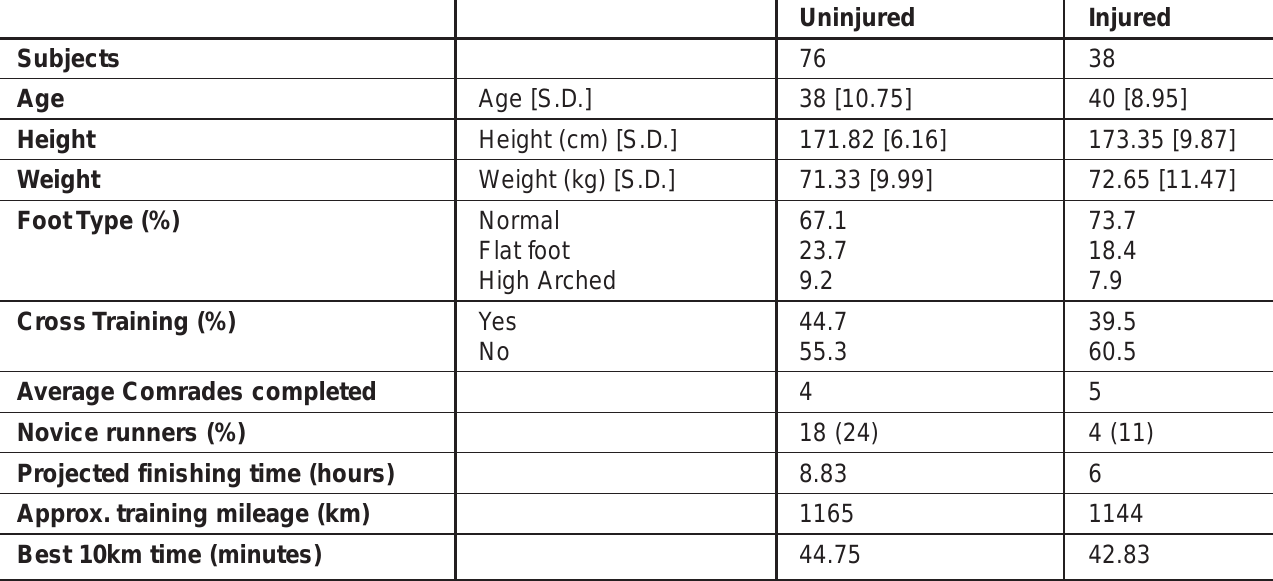
Table 1: Referencing subjects and training